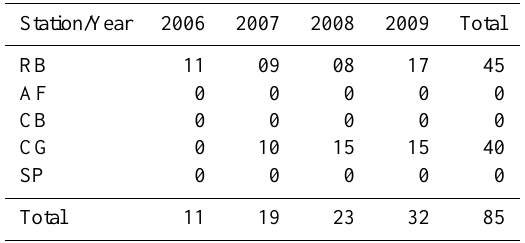
Table 3. AERONET correlative measurement days for CALIOP closest approach distances less than